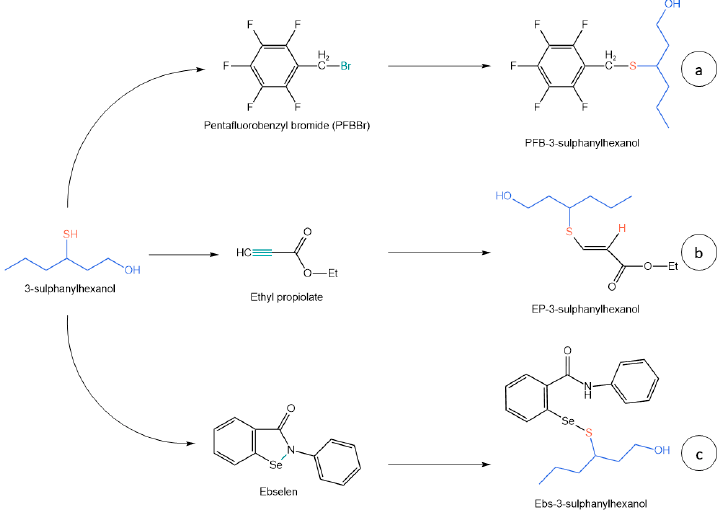
Figure 2. Different derivatization pathways in VTs’ derivatization. ( a ) Reaction with PFBBr; ( b ) Reaction with ethyl propiolate; ( c ) Reaction with ebselen. Table 1. GC-MS and LC-MS methods presented for VTs’ determination and related highlights.